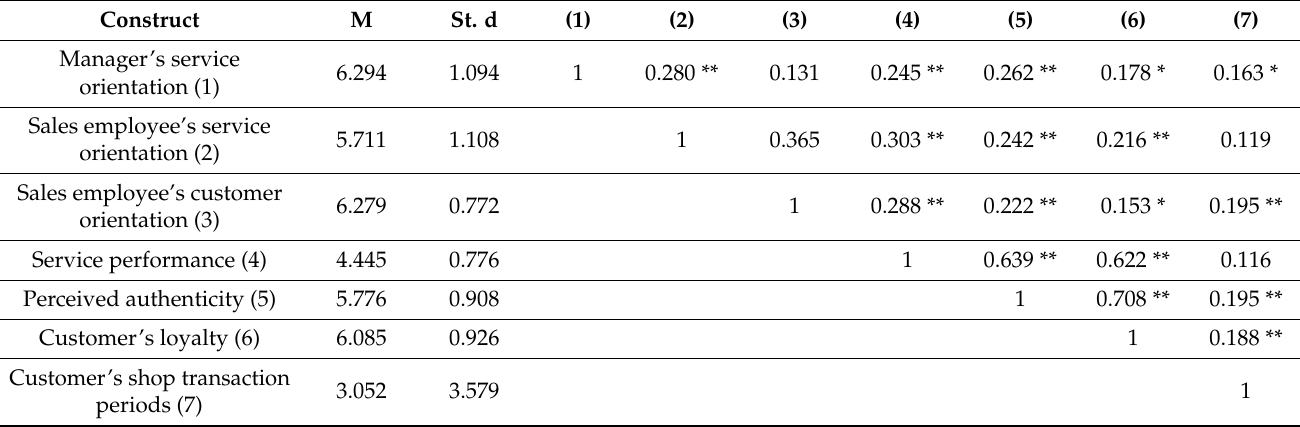
Table 3. Results of the correlation analysis.